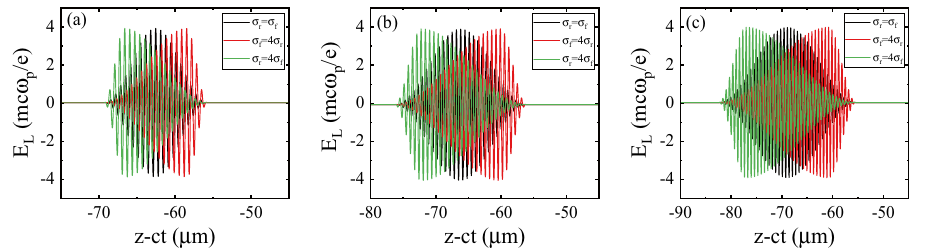
Figure 5. Different initial temporal profiles for the ( a ) 20 fs, ( b ) 30 fs and ( c ) 40 fs pulses, respectively. The red, black, and green colors denote the positive skew ( σ f = 4 σ r ), the symmetric ( σ r = σ f = σ 0 / 2 ), and the negative skew ( σ r = 4 σ f ) cases,